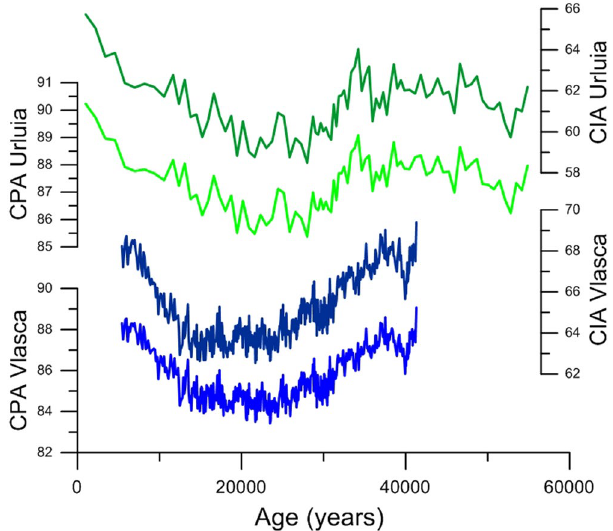
Figure 4. Weathering indices (CIA and CPA) for the Urluia and Vlasca